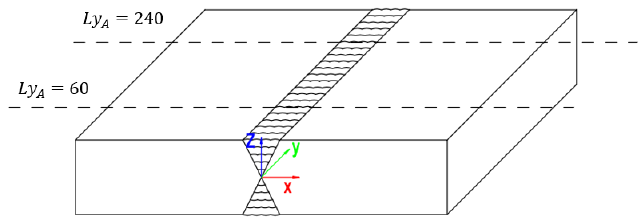
Figure 18. The paths on the transverse direction through the quintile points of the weld (unit mm).